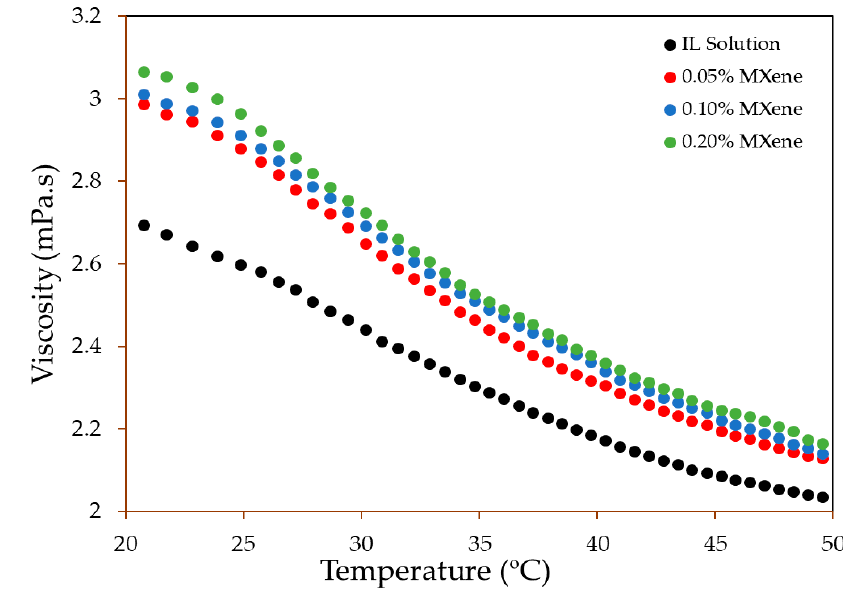
Figure 11. Dynamic viscosity of IL aqueous solution and ionanofluids with various concentration of Ti 3 C 2 .